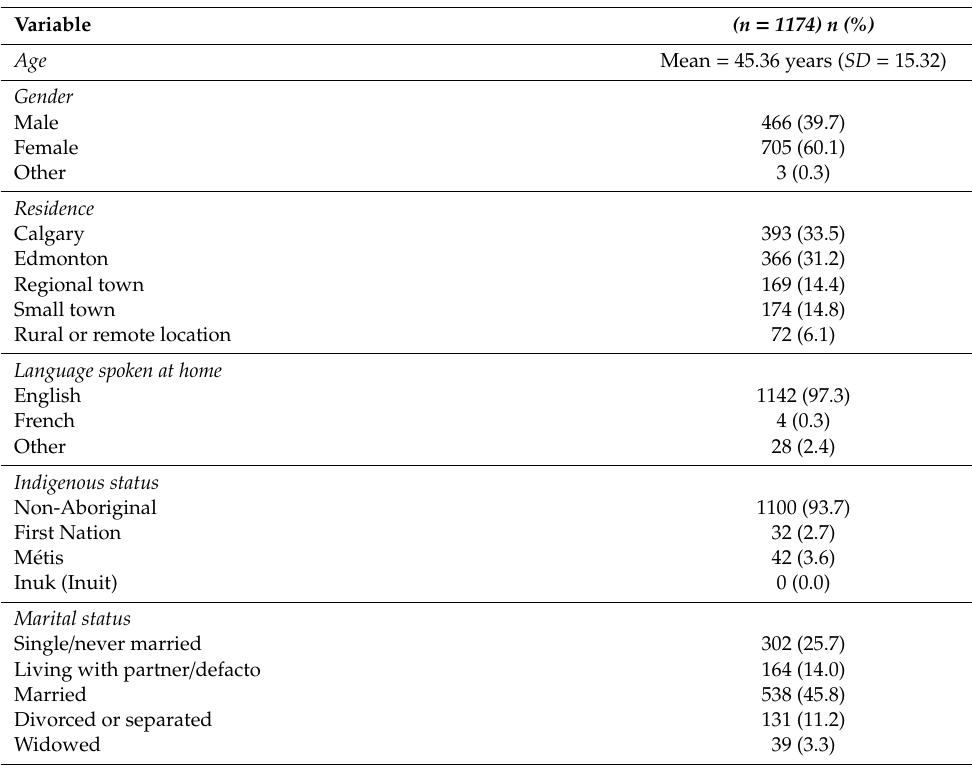
Table 1. Demographic characteristics of the